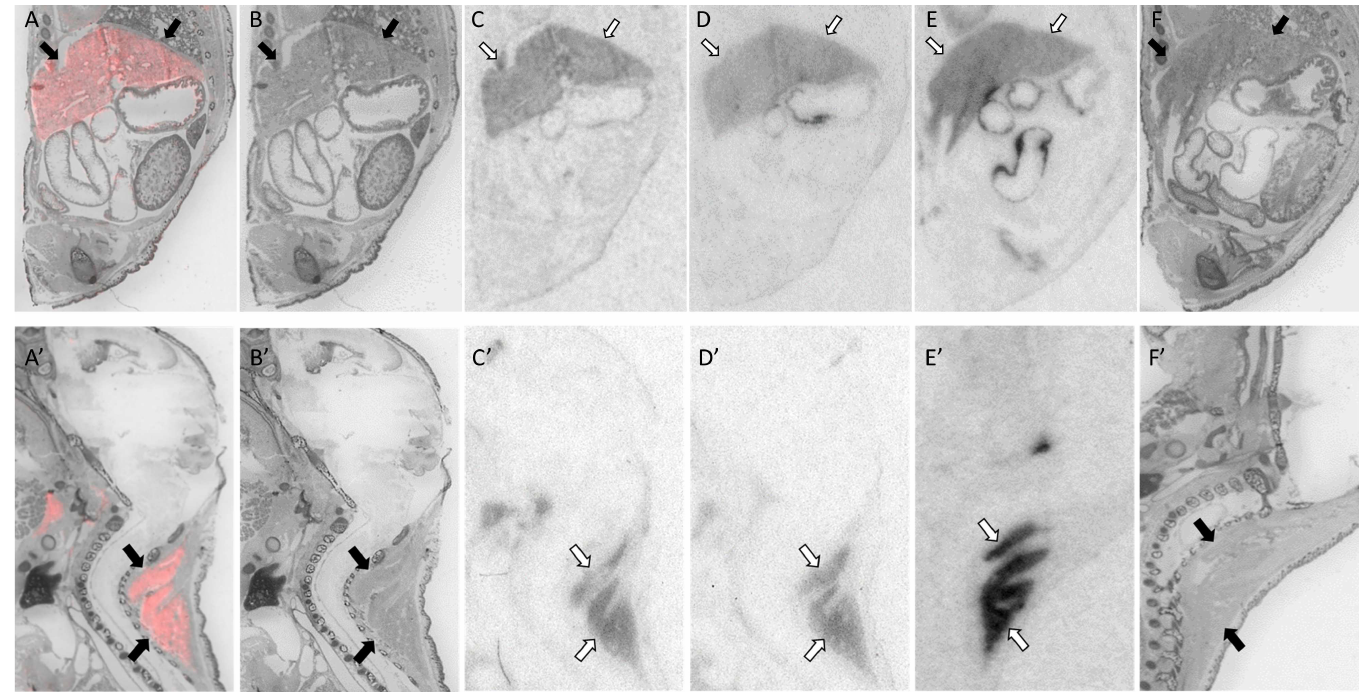
Fig 7. Nonspecific binding in the liver (A-F) and brown adipose tissue (A’-F’) of a P0 male mouse. Pseudo-color composite (OXTR in red, cresyl violet counterstain in gray) (A, A’), followedby cresyl violet counterstain (B, B’), with black arrows indicating region of interest. Nonspecific bindingis indicated by white arrows in the 0 nM OXT competition(C, C’), followedby 1000nM OXT competingwith OVTA radioligand that did not reduce the signal (D, D’). Nonspecificbindingwas also present in OXTR KO mice (E, E’), followedby the post-processed cresyl violet tissue of the OXTR KO (F,